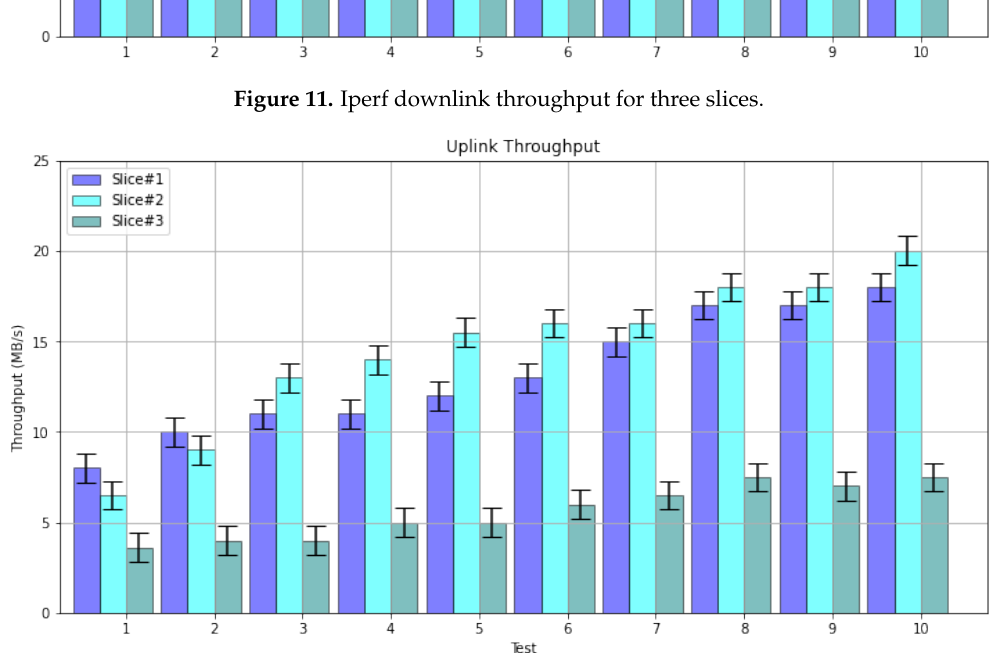
Figure 12. Iperf uplink throughput for three